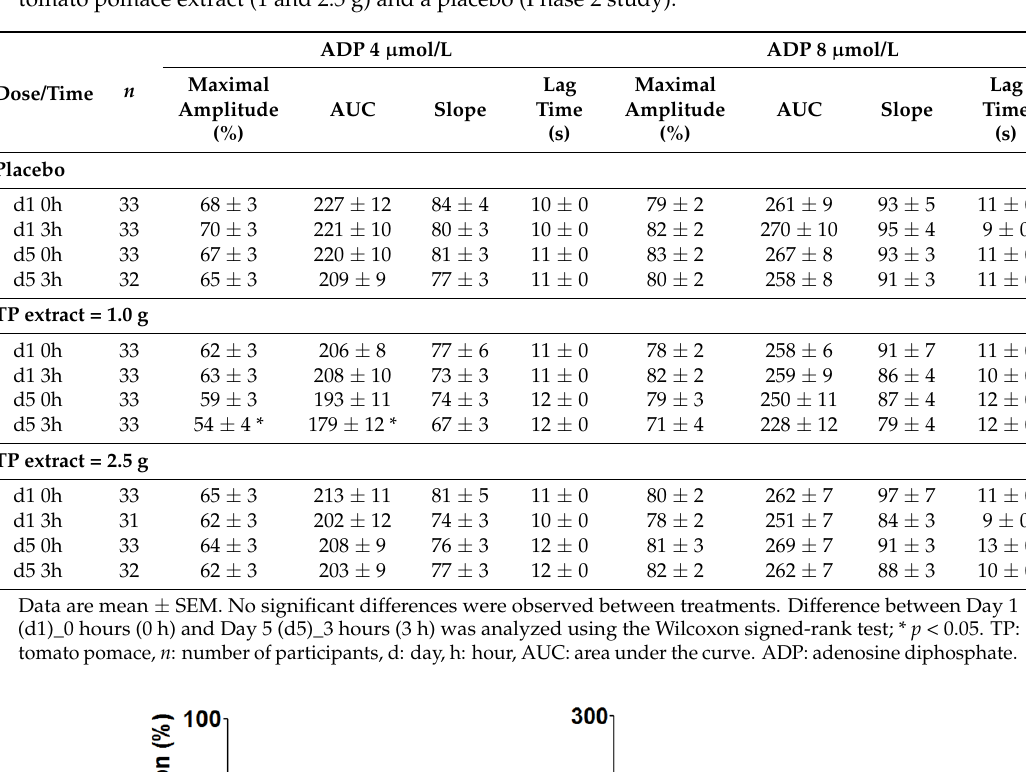
Table 4. Acute and chronic effects on platelet aggregation before and after ingestion of two doses of tomato pomace extract (1 and 2.5 g) and a placebo (Phase 2 study).